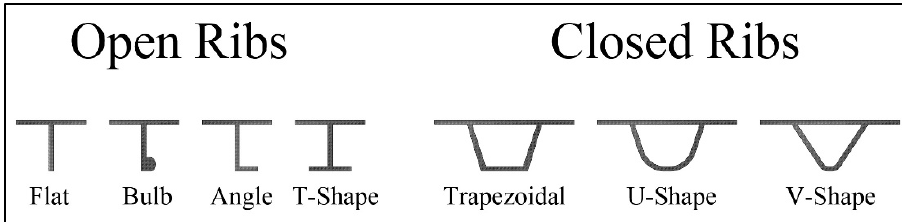
Figure 1. Common open- and closed-rib sections.